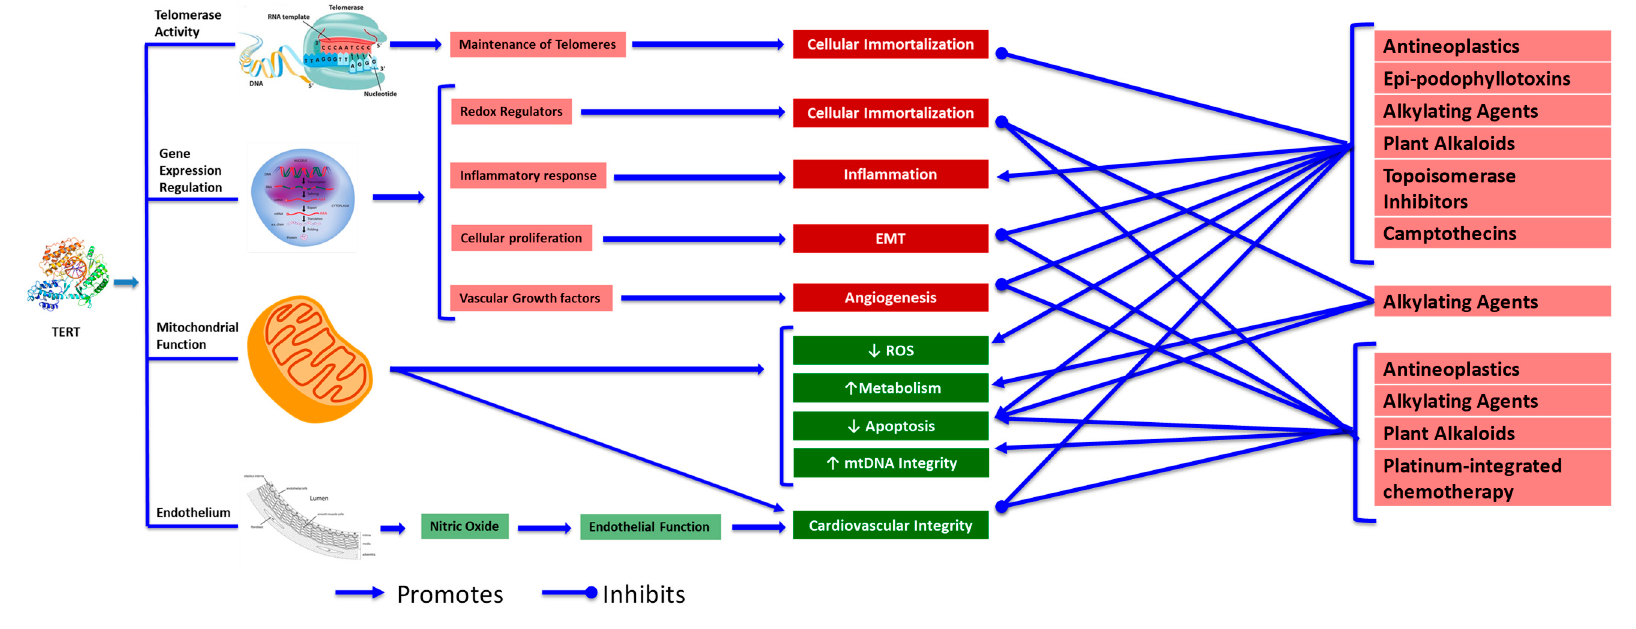
Figure 2. Hypothesized therapeutic nature of telomerase to preserve mitochondrial and endothelial function, therefore mitigating cardiovascular disease phenotypes, distinct from its previously detailed oncogenic role (gene expression regulation/telomere maintenance). TERT is known to control telomerase activity as well as regulate gene expression. Through its role in regulating telomere length, connection with the inflammatory response, cellular proliferation and vascular growth factors, telomerase has been shown to contribute to cellular transformation, inflammation, epithelial-mesenchymal transition (EMT) and angiogenesis. Due to these apparent connections with cellular proliferation and transformation, conventional wisdom has characterized TERT as an oncogene. Interestingly, recent evidence has emerged which presents a revolutionary therapeutic nature of telomerase in regard to preserving mitochondrial function as well as maintaining endothelial integrity through restoration of nitric oxide-mediated vasodilation and preserving endothelial function. This interconnectedness suggests the therapeutic nature of telomerase in relation to maintaining cardiovascular integrity. Specifically, telomerase has been shown to ameliorate excess ROS production, regulate metabolism, maintain conventional apoptotic function and preserve mt DNA integrity. Each beneficial component relates directly to various types of chemotherapeutic agents, which have been shown to be characterized by and include such damage, therefore proposing a role of telomerase to counter chemotherapeutic-derived cardiovascular dysfunction.